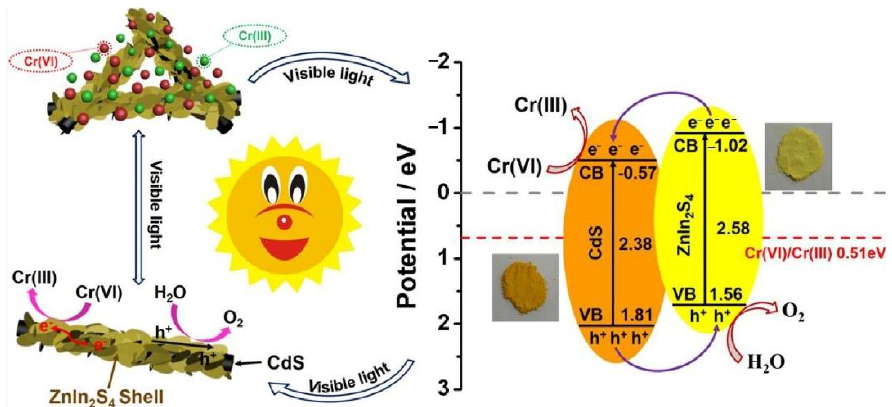
Figure 5. Schematic illustration of the reaction mechanism for reduction of Cr(VI) over 3D ZnIn 2 S 4 /CdS composite under visible light irradiation [54] . Copyright, 2018 Elsevier Inc.